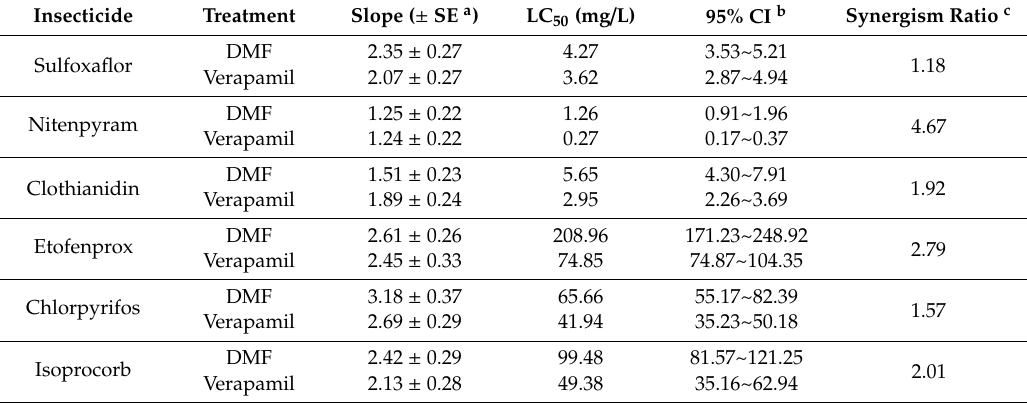
Table 2. Susceptibility of N. lugens nymphs to insecticides after treatment with inhibitor.